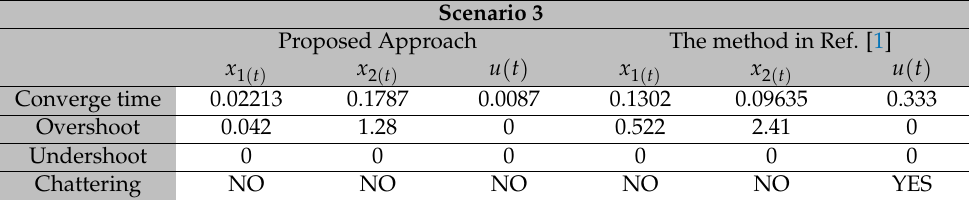
Figure 14. Adaptation gains [1] . Table 3. Comparing the responses of the DBC system under the conditions of scenario 3.